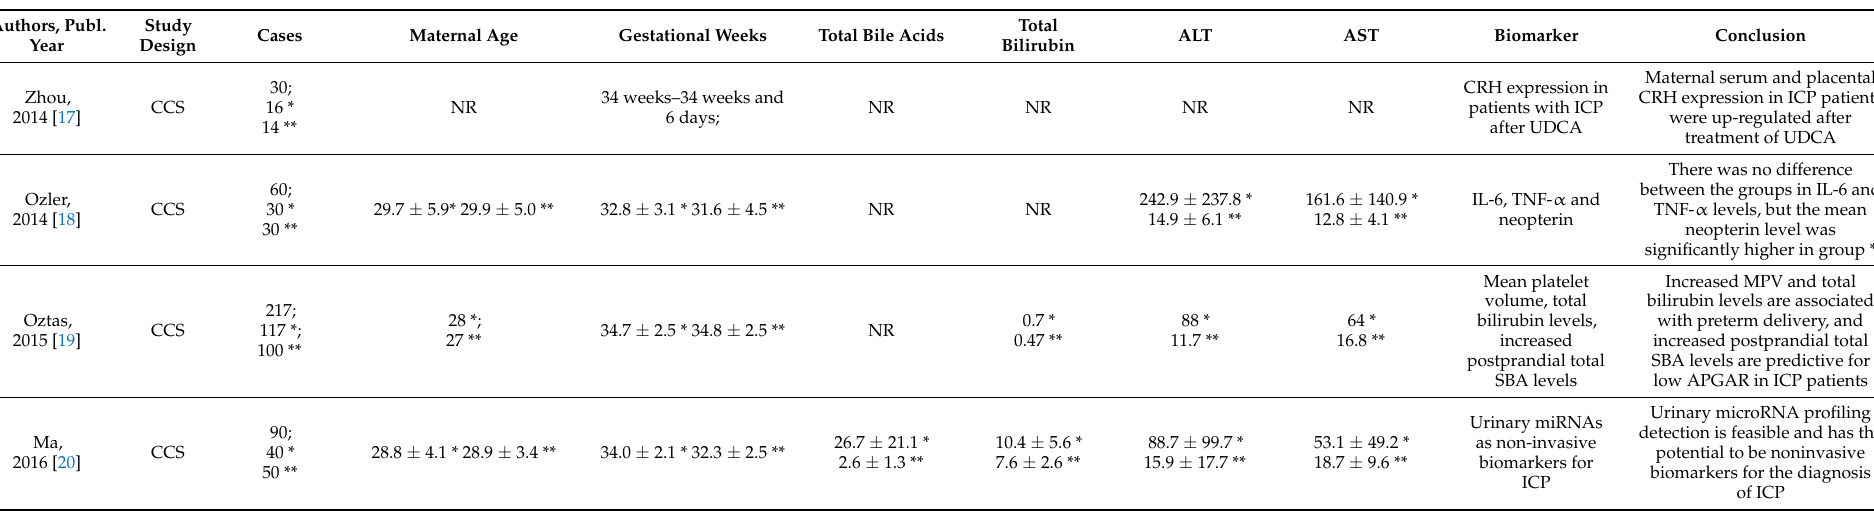
Table 3. Laboratory markers and genetic biomarkers of ICP. * ICP, ** Control, CCS = case control study; ICP = intrahepatic cholestasis of pregnancy; NR = not reported; NI = no information; TBA = total bile acids; OS = oxidative stress; LncRNAs = long noncoding RNAs; MPV = mean platelet volume; SBA = serum bile acids; CRH = corticotropin-releasing hormone; UDCA = ursodeoxycholic